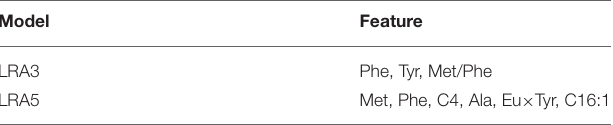
to validate the model, including 37 PKU patients and 74 false- positive patients. The male-to-female ratio was ∼ 1:1.13; the average age at the time of blood collection was 4.5 days, and the average weight was 3.4